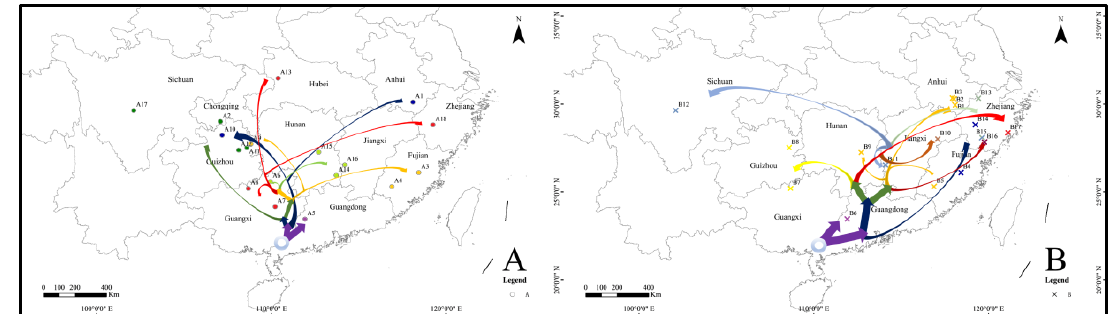
Figure 7. Dispersal routes of lineage A ( left ) and lineage B ( right ). Reconstructions are based on the network and genetic analysis. The arrows represent possible spread directions but not actual dispersal routes. Different colored arrows represent different branches in Figure 4.